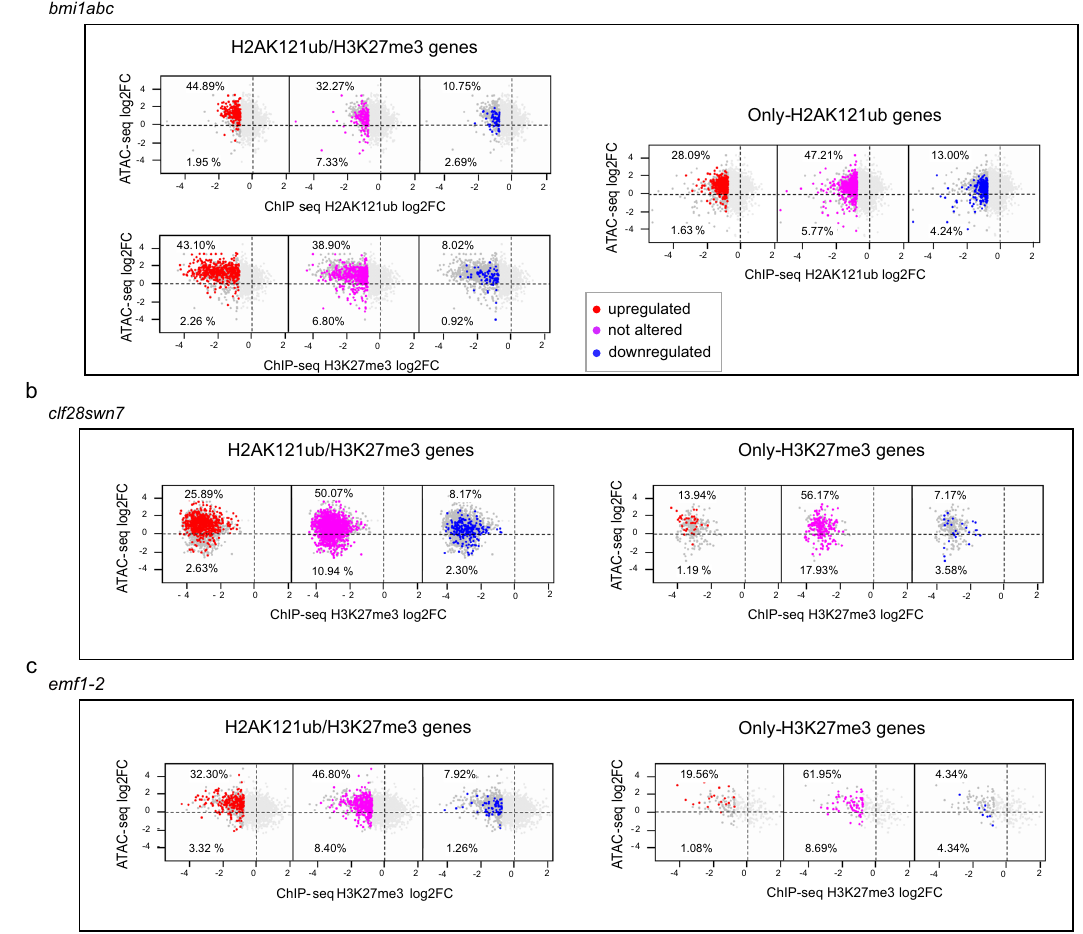
Fig. 5 Increased chromatin accessibility in PcG mutants is not necessarily accompanied by gene expression. a Scatter plots showing the relationship between THS accessibility and marks levels (H2K121ub or H3K27me3) at H2AK121ub/H3K27me3 (left) and only-H2K121ub marked genes (right) in bmi1abc mutant. b Scatter plots showing the relationship between THS accessibility and H3K27me3 levels at H2AK121ub/H3K27me3 (left) and only- H3K27me3 marked genes (right) in clf28swn7 mutant. c Scatter plots showing the relationship between THS accessibility and H3K27me3 levels at H2AK121ub/H3K27me3 (left) and only-H3K27me3 marked genes (right) in emf1-2 mutant. In each panel, top numbers indicate the percentage of genes displaying altered or unaltered expression levels within the subset of genes showing less than 60% of WT H2K121ub or H3K27me3 (cutoff log2FC ≤ − 0.74) and increased accessibility compared to WT. While bottom numbers indicate the same for the genes with less than 60% of WT H2K121ub or H3K27me3 and decreased accessibility compared to WT. The sum of top and bottom numbers from each panel represent 100% of the genes with less than 60% of WT H2K121ub or H3K27me3 and altered accessibility compared to WT. Upregulated expression is indicated in red, not altered expression in pink, and downregulated expression in blue. Source data are provided as a Source Data fi